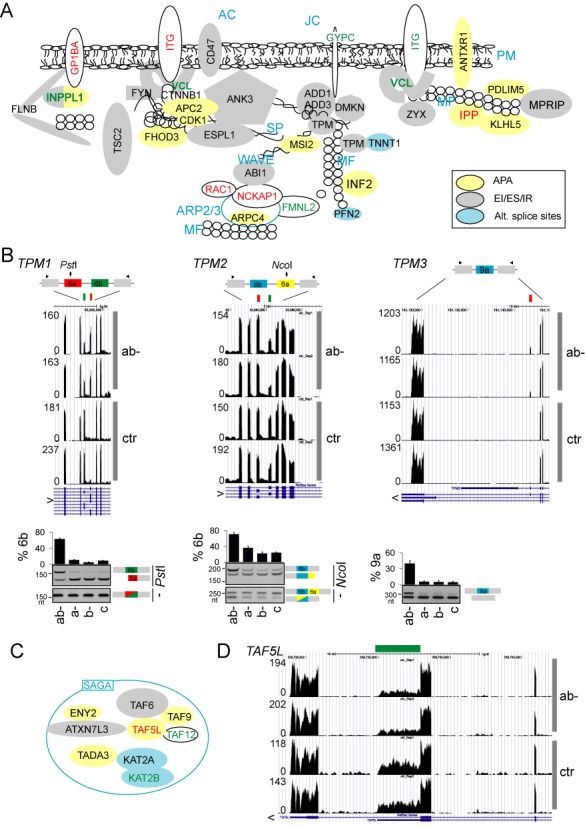
Examples of U2AF(35)-regulated genes involved in cytoskeleton organization and chromatin modification. (A) Exon-centric regulation of actin dynamics. Protein products are drawn as colored shapes in a cellular context. Red and green text shows genes that were upregulated and downregulated in ab- cells, respectively; blue text denote protein complexes or subcellular structures: PM, plasma membrane; MF, microfilaments; SP, spectrin; AC, ankyrin complex; JC, junctional complex. EI, exon inclusion; ES, exon skipping; IR, intron retention. Actin monomers are schematically shown as small circles. ITG shapes denote multiple integrins upregulated and downregulated in ab- cultures (Supplementary Table S3). (B) Identification of U2AF(35)-sensitive exons in the tropomyosin genes (upper panels) and their validation by RT-PCR (lower panels). Restriction enzymes to establish the identity of mutually exclusive exons are indicated to the right; small fragments of digested products are not shown. Alternative exons are coloured, arrowheads denote PCR primers. (C) Components of the SAGA complex influenced by U2AF35 depletion. A legend for colored shapes is in panel A. (D) A genome browser view of a differentially used APA in a representative SAGA transcript. Additional SAGA transcripts are shown in Supplementary Figure S5F and S5G.